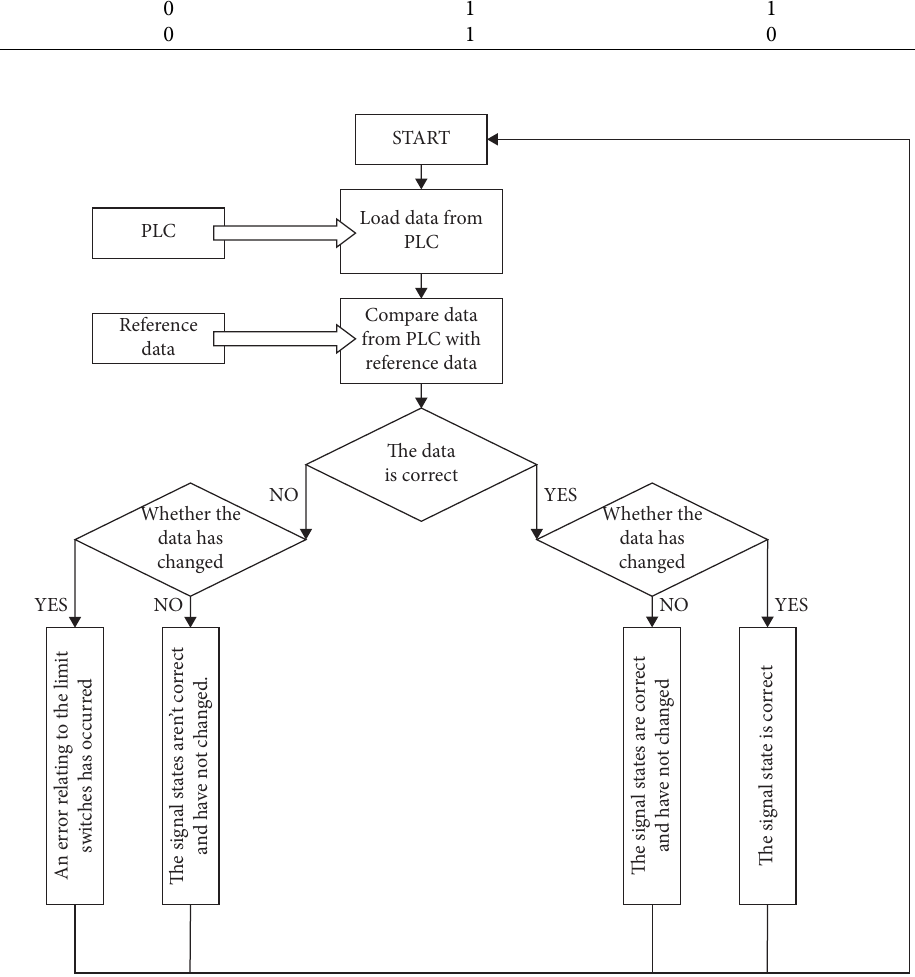
Figure 8: Scheme of the algorithm for detecting changes in the operation of the manipulator.